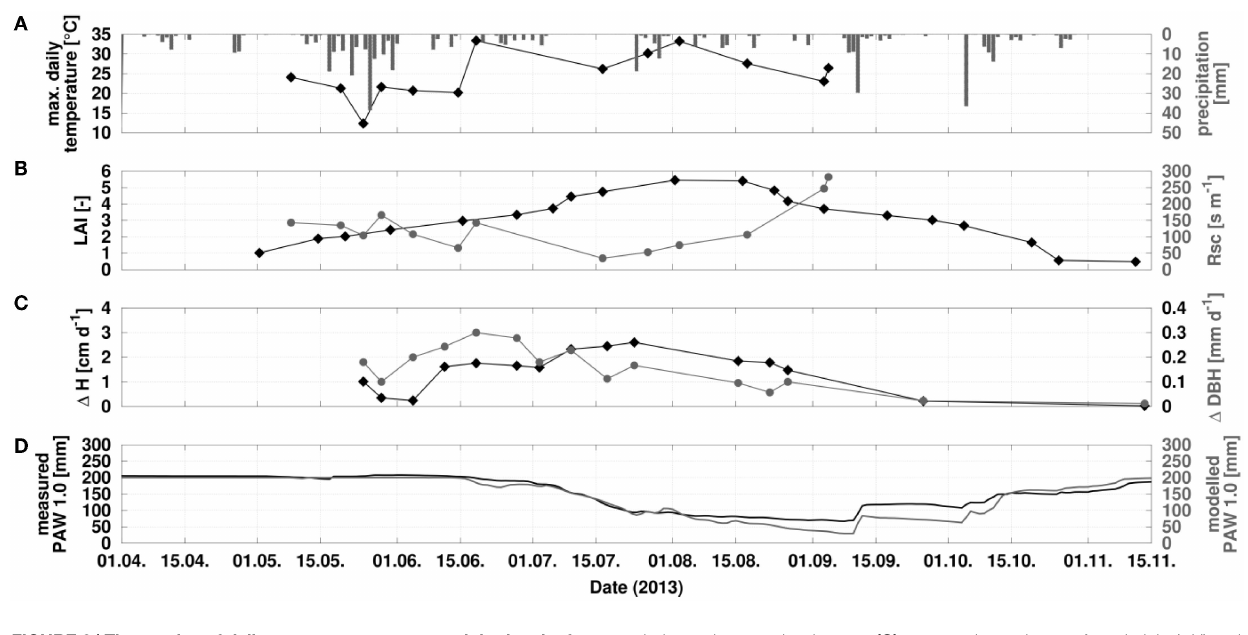
index and stomatal resistance; (C) measured growth rate of tree height ( ∆ H) and diameter at breast height ( ∆ DBH); (D) measured and modeled course of plant available water, calculated until 1m soil depth (PAW1.0). Black drawings with diamonds belong to the right axis, gray ones with circles to left axis.